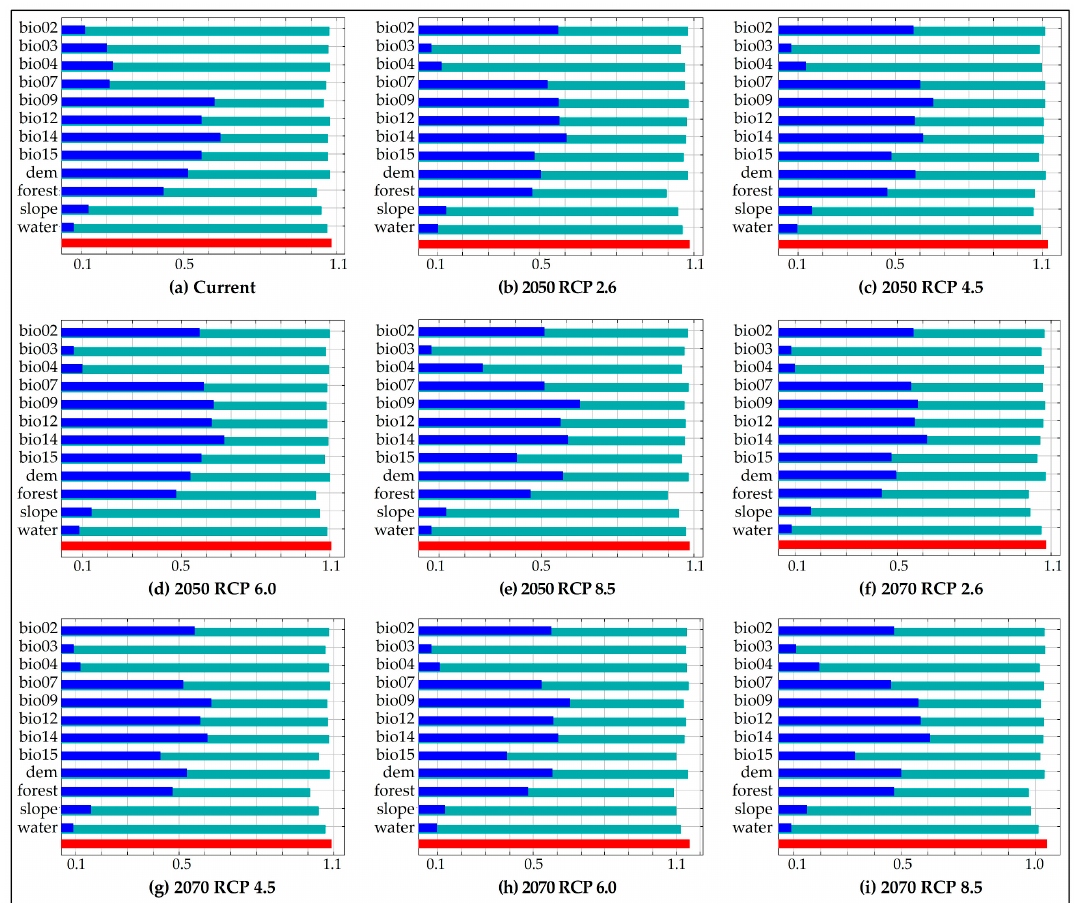
Figure 3. Jackknife test of regularized training gain of environmental variables to MaxEnt models under current conditions ( a ) and climate change scenarios in 2050 ( b – e ) and 2070 ( f – i ) of the spectacled bear in Amazonas (Peru). Regularized training gain without variable (green), with only variable (blue) and with all variables (red). Variables of greatest importance according to jackknife for the models: mean temperature of the driest room (bio09) and precipitation of the driest month (bio14).